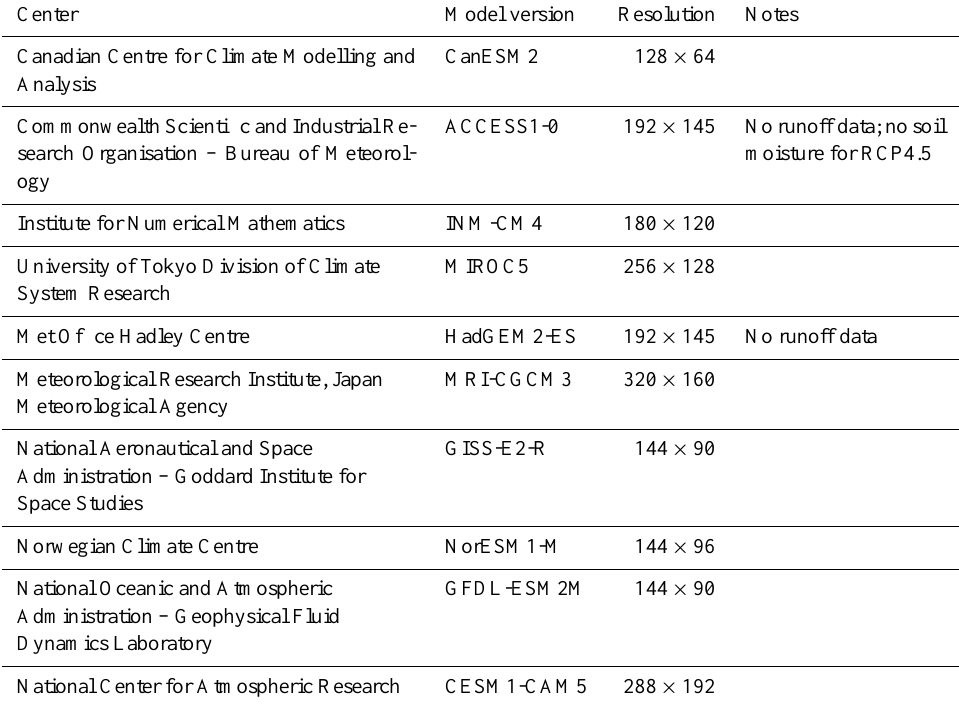
Table 1. CMIP5 models used in this